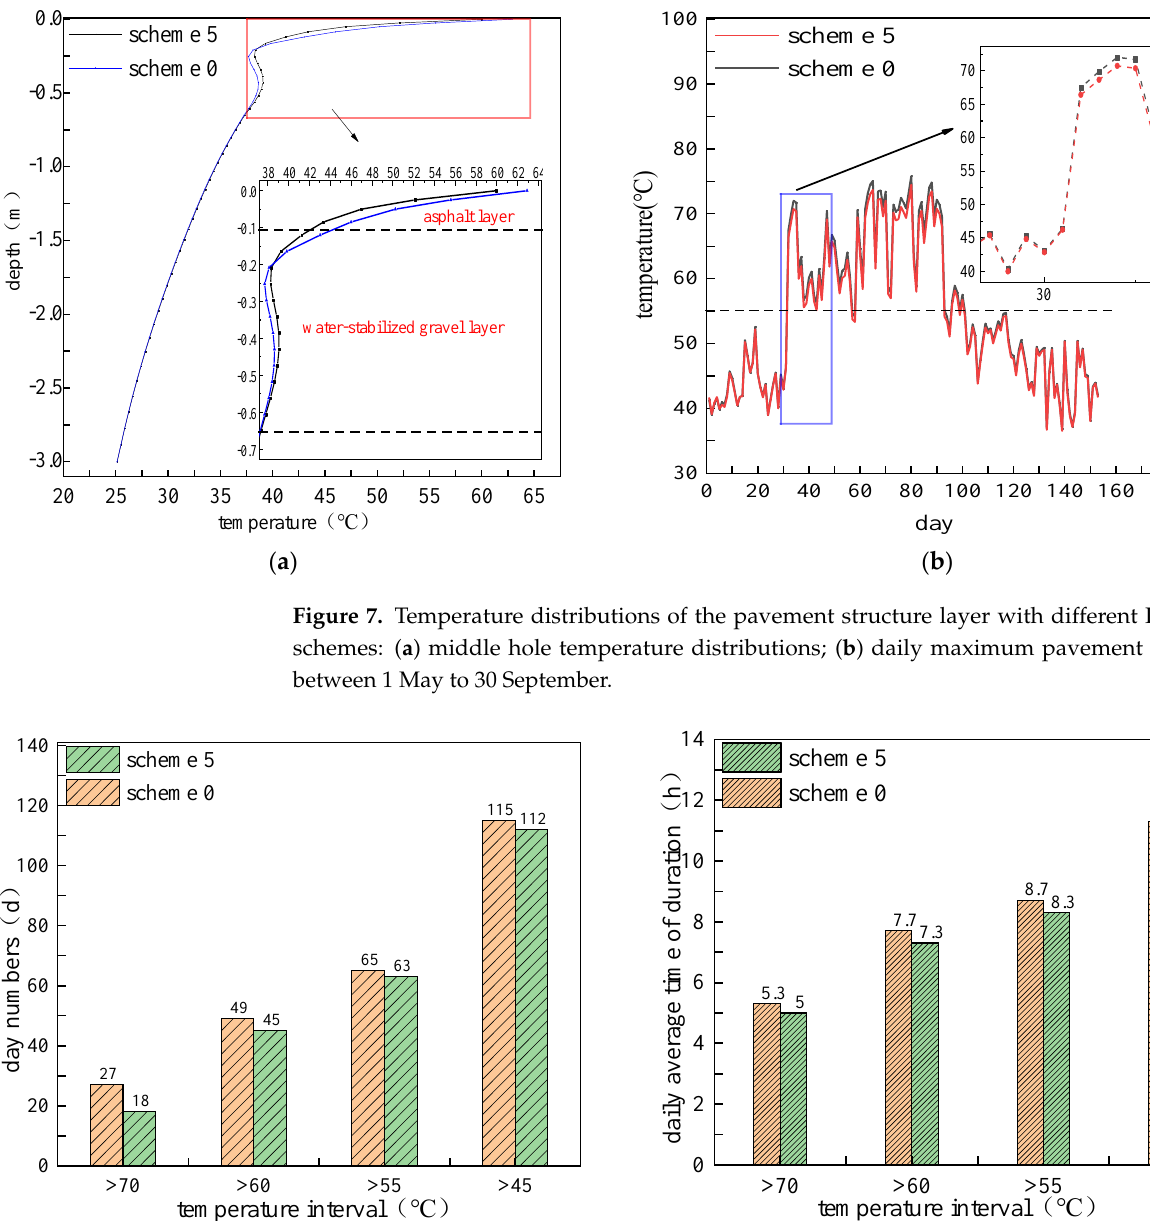
asphalt up-layer Figure 9. Temperature distributions of the asphalt layer with different PCM mixing ratios on July 15.